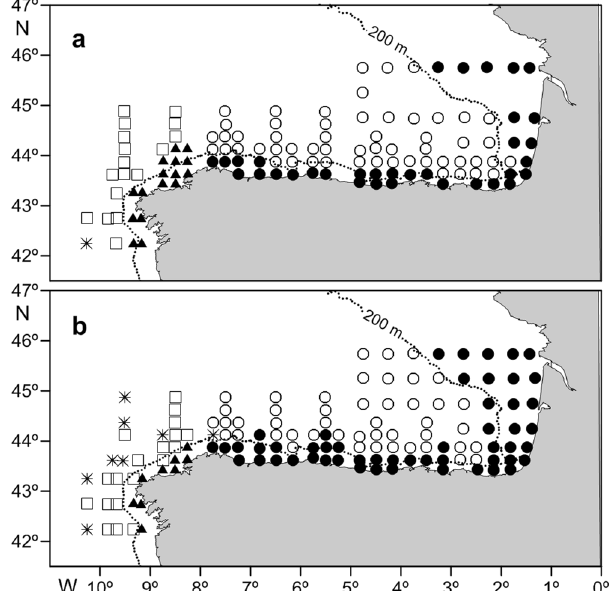
Figure 6. Geographic location of the larval fish assemblages: ( a ) during the CAREVA cruise and ( b ) during the JUREVA cruise, defined by cluster analyses and non-metric multidimensional scaling ordination (nMDS): ( ▴ ) shelf assemblages in the Atlantic region (AR); ( ◽ ) off-shelf assemblages in the AR; ( ⚫ ) shelf assemblages in the southern Bay of Biscay region (SBB); ( ⚬ ) off-shef asssemblages in the SBB; ( )